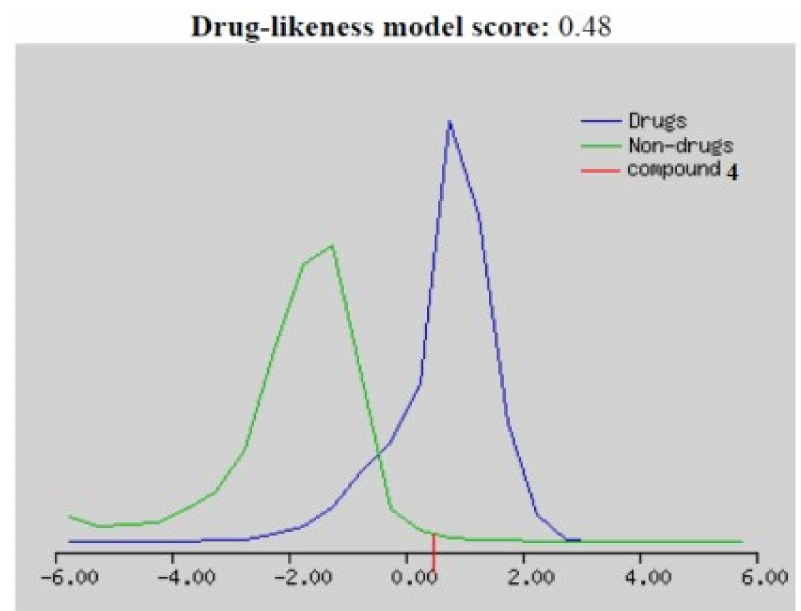
Figure 5. Plotting of Drug-likeness score of compound 4 using MolSoft. Non-drug like behavior (green-colored curve) and drug-like behavior (blue-colored curve). Compounds with zero or negative value should not seem to be as drug. Compound 4 has a value of 0.48 (positive value) as a drug-likeness score. It should be regarded as